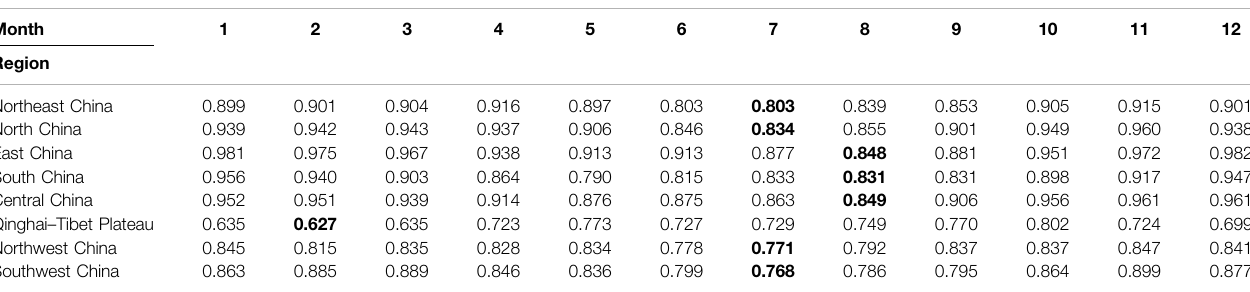
TABLE 5 | Correlation coef fi cients for the cross-validation of precipitation anomaly percentage.